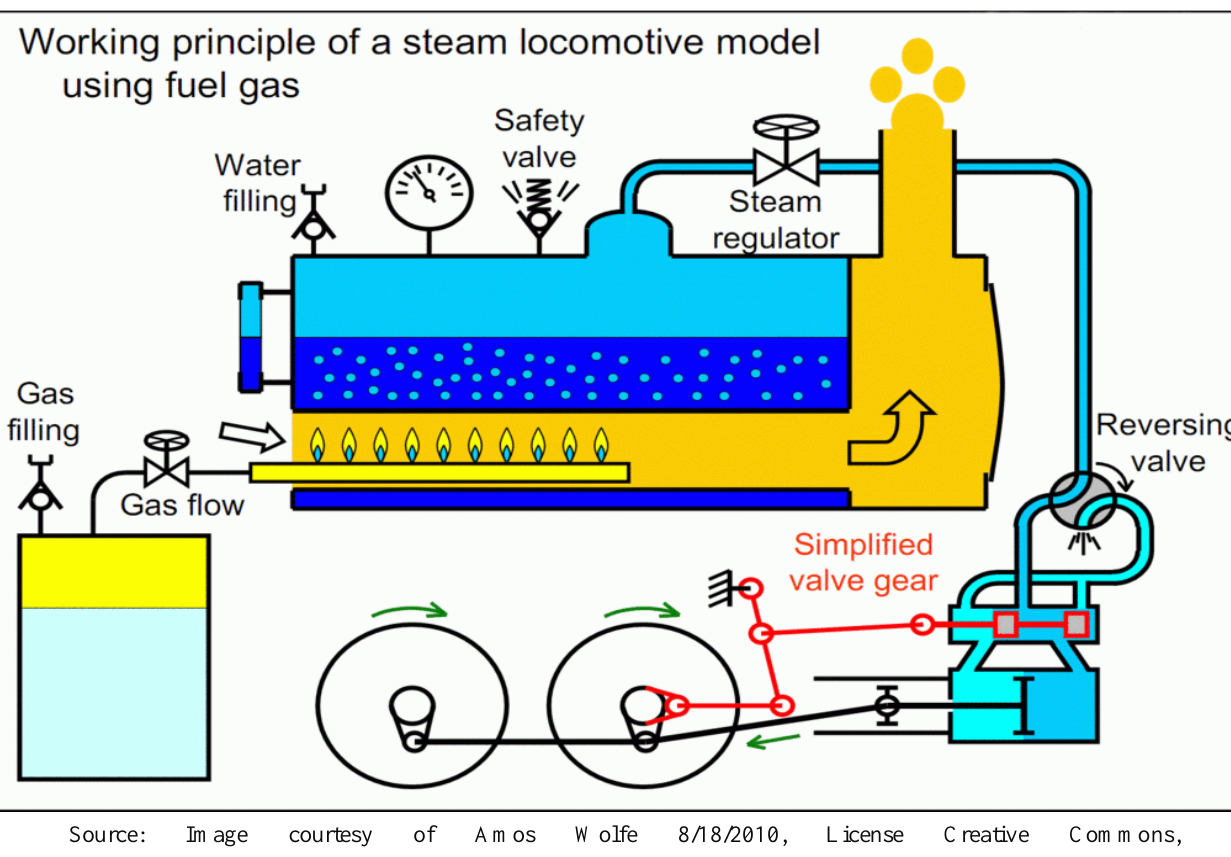
Figure 1. Schematic View of a Steam